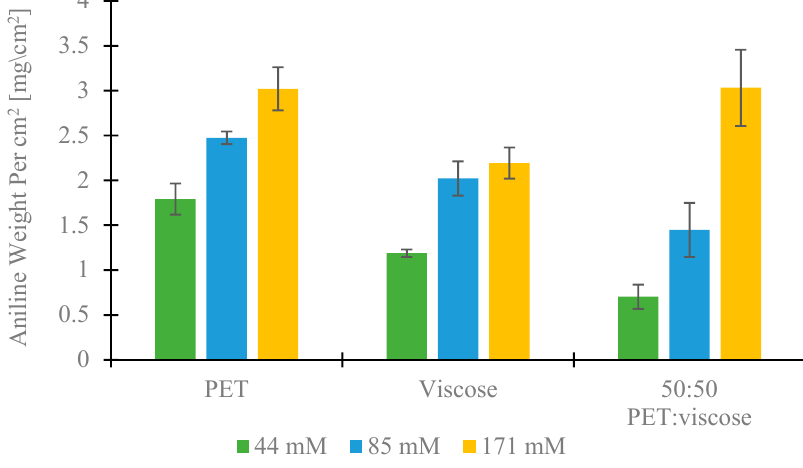
Figure 2. Weight gain of PANI per cm 2 of fabrics.